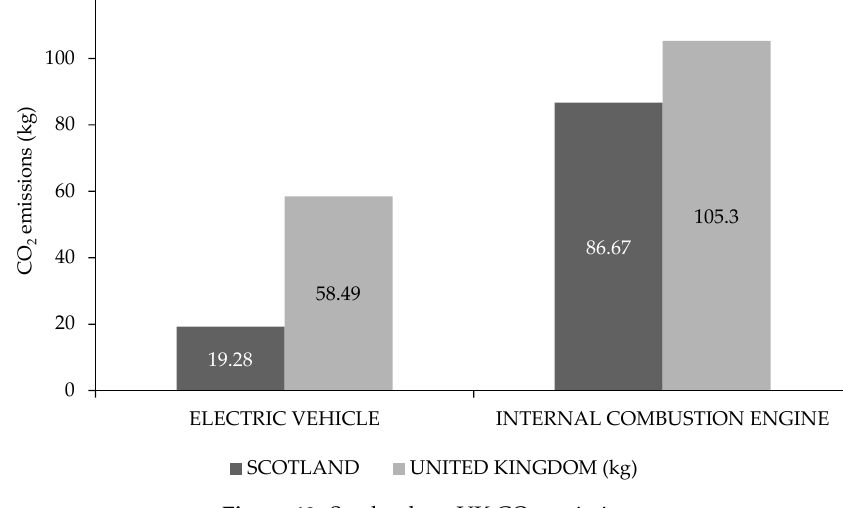
Figure 12. Scotland vs. UK CO 2 emissions.